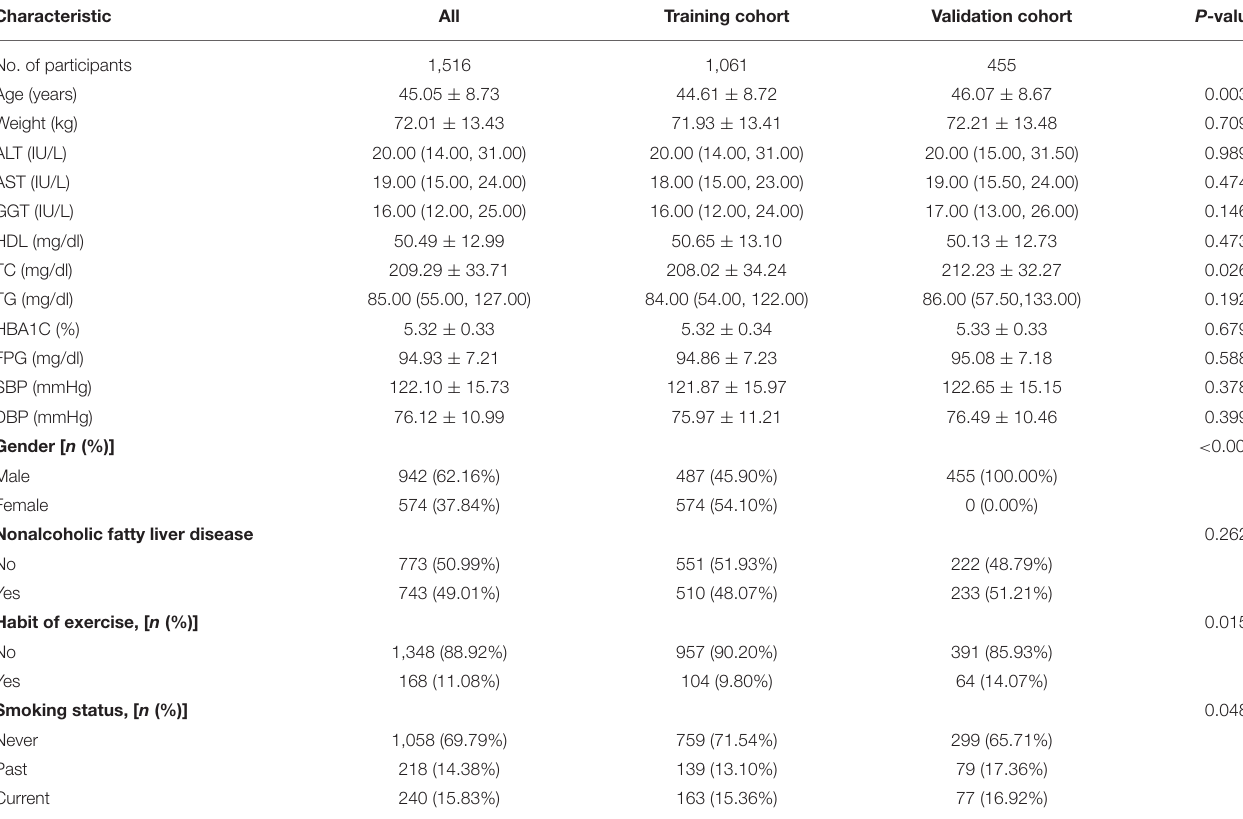
TABLE 1 | Demographic and clinical characteristics of study population in the derivation and validation cohorts. Characteristic All Training cohort Validation cohort P